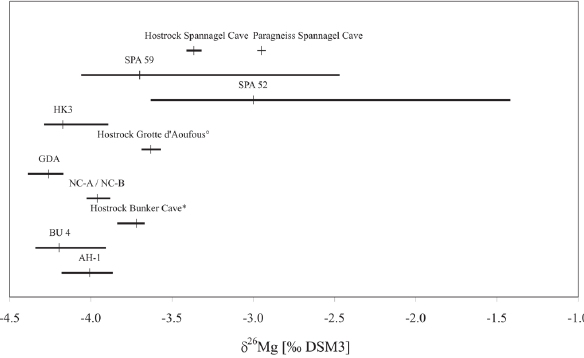
Fig. 2. Overview of Mg-isotope data of the studied speleothems and host rock. Mean value is indicated by thin vertical line; width of horizontal bars indicates data range. Asterisk (*) indicates data from Immenhauser et al. (2010), and circle ( ◦ ) indicates data from Buhl et al.